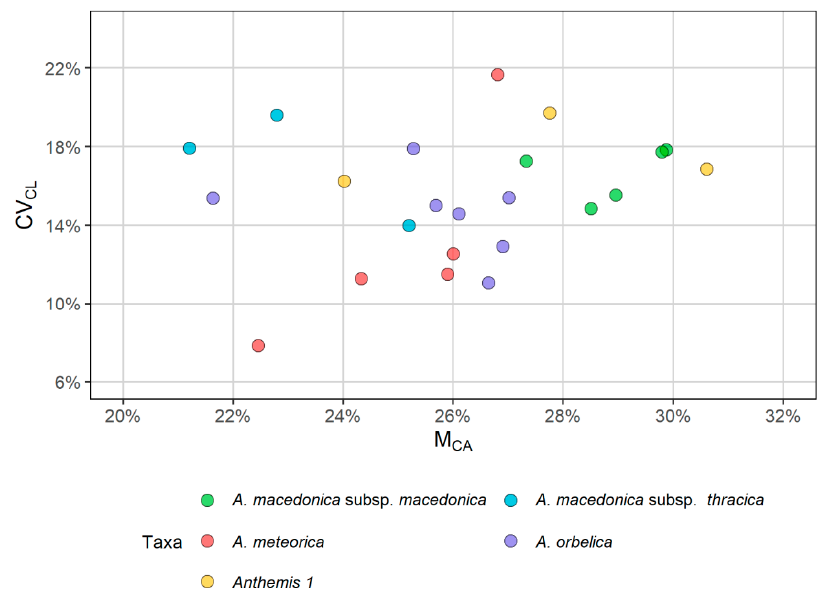
Figure 9. Scatter plot showing the karyotype indices of the intrachromosomal (M CA ) and interchromosomal (CV CL ) asymmetry for all the studied taxa in the Anthemis macedonica group.